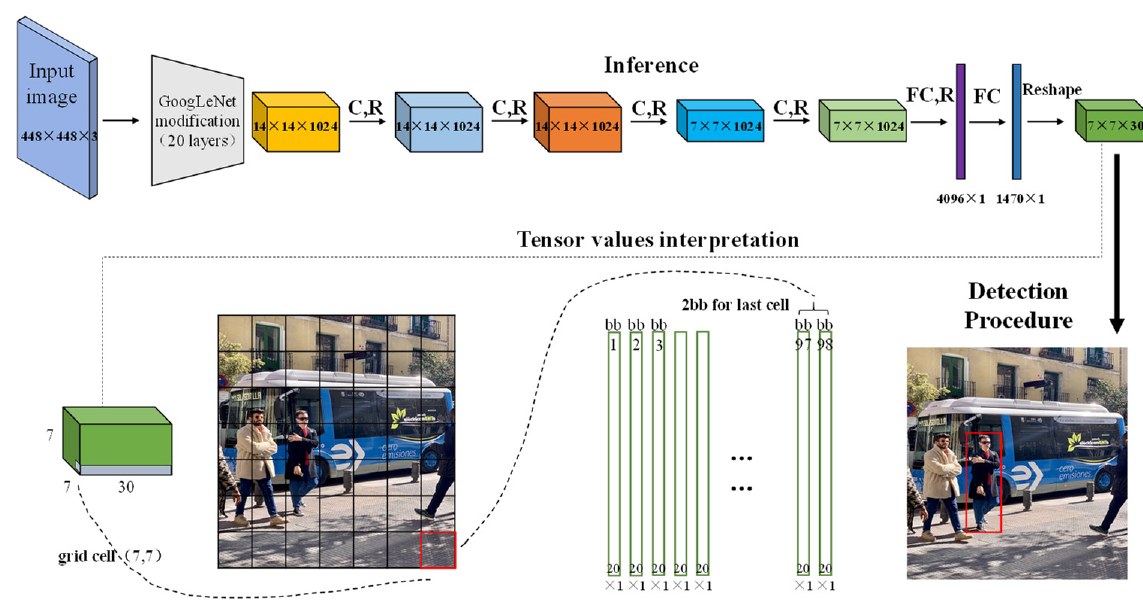
Figure 1. Schematic diagram of YOLO deep learning network structure.